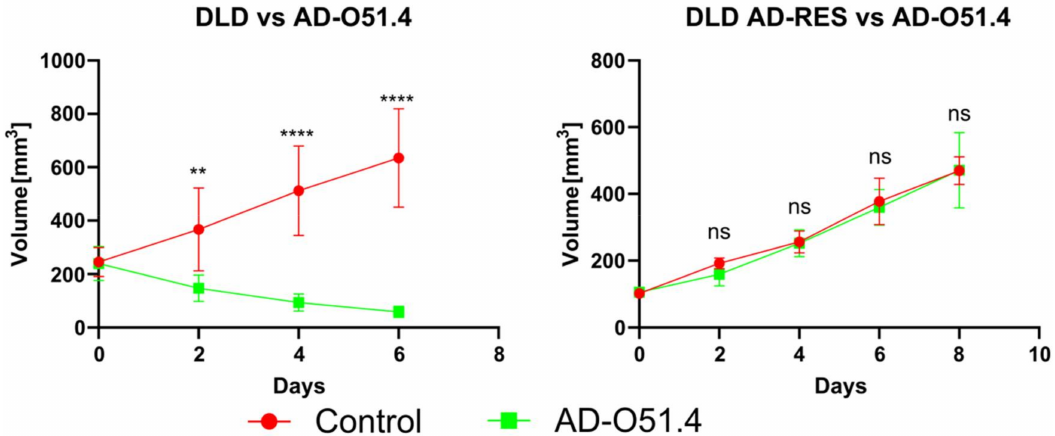
Figure 6. In vivo studies show acquired resistance to AD-O51.4 preservation after xenograft implantation. AD-O51.4 was intravenously administered five times every other day at 50 mg/kg (4 times in the case of the native DLD-1 line). Groups size n = 6, each mouse bearing one tumor, ± SEM. ** p < 0.01, **** p < 0.0001; ns: not significant.